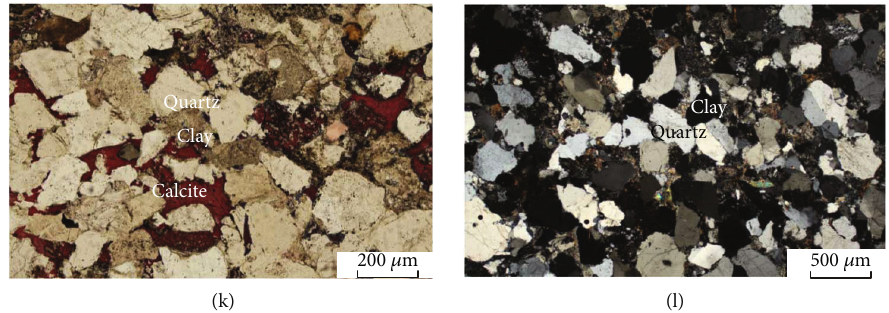
Figure 4: Pore characteristics of Shan 1 reservoir. (a) Intergranular solution pore, Cn105 well, 2482.84m. (b) Intergranular solution pore, Cn109 well, 2221.37m. (c) Micro fi ssure, Cn93 well, 2276.68m. (d) Rock debris solution pore, Cn105 well, 2488.78m. (e) Rock debris solution pore, Cn98 well, 2087.1m. (f) Feldspar solution pore, Cn98 well, 2096.18m. (g) Calcite cementation, Cn98 well, 2093.71m. (h) Calcite metasomatism